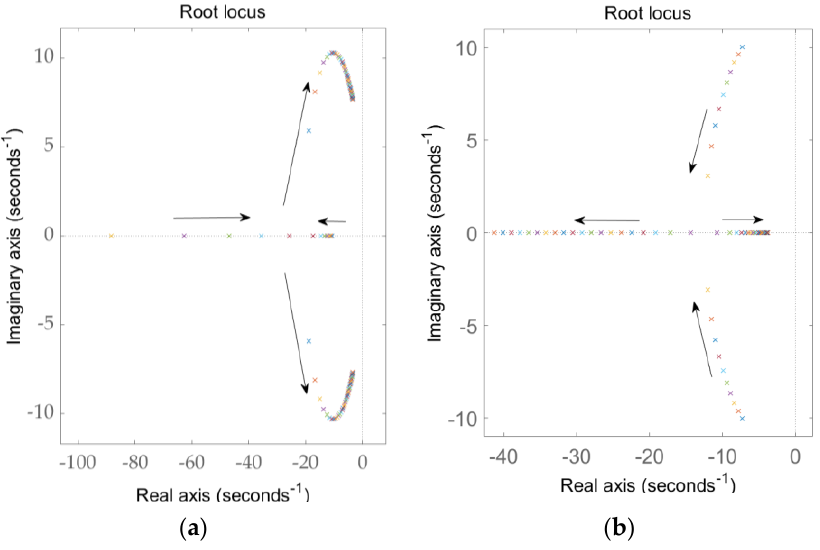
Figure 12. Root locus. ( a ) Root locus under J parameters change; ( b ) root locus under D parameters change. (The direction of the arrow indicates that the parameter is increased).